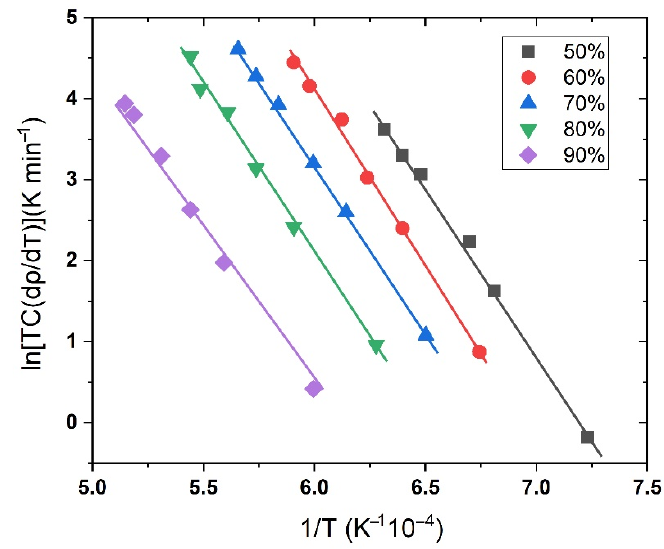
Figure 5. The Arrhenius plot of ln[TC(d ρ /dT)] vs. (1/T) for the non-isothermal sintering of the powder compacts at different heating rates corresponding to the same relative density.